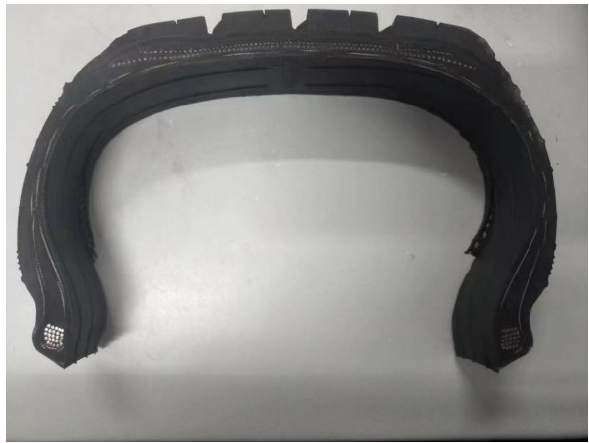
Figure 8. Cross-section of 175/75R14 tire.